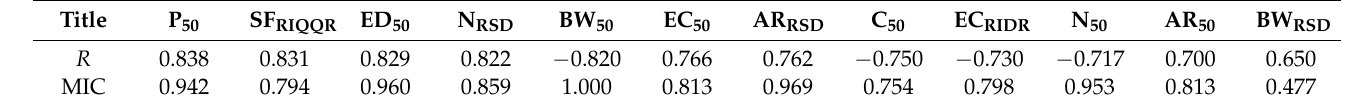
Table 4. Twelve properties that led to the highest coefficients of correlation with D 32